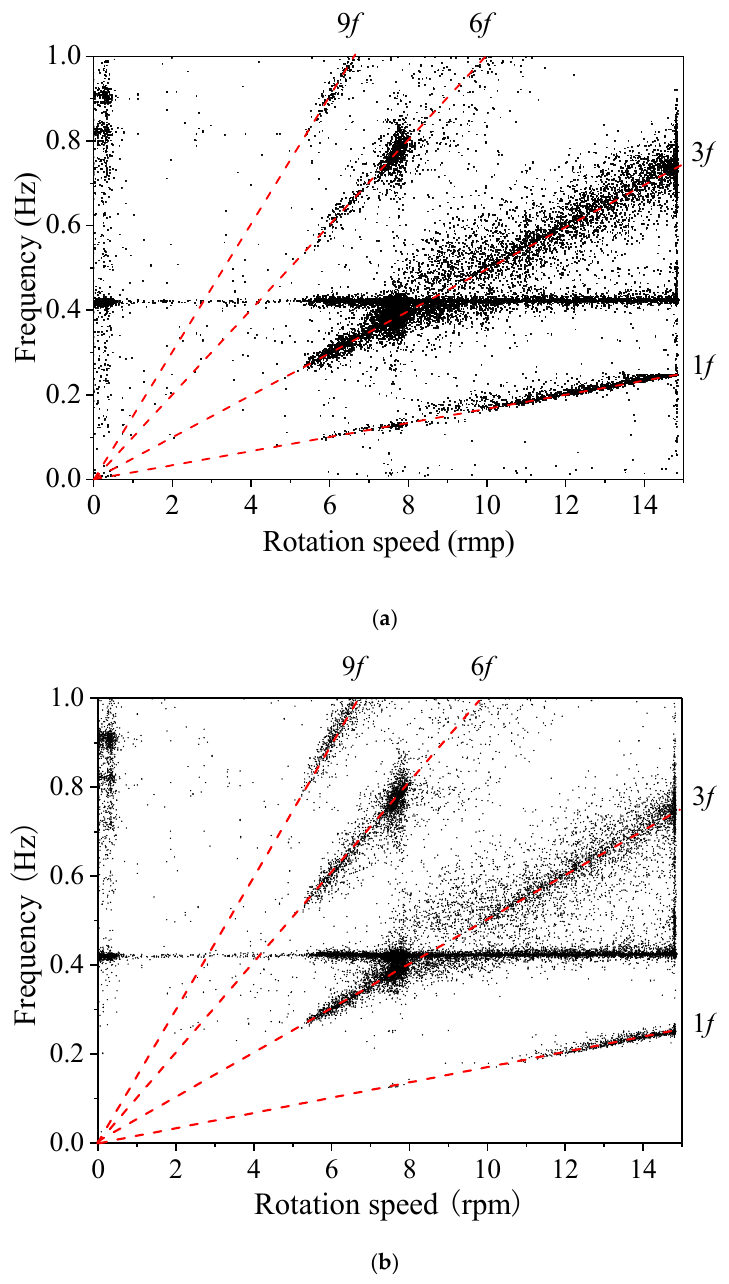
Figure 12. Analytical and experimental frequency Campbell diagram based on low filtered and re-sampled strain and acceleration responses. ( a ) Eigen frequencies estimated by the dynamic strain responses acquired from S8 and S10; ( b ) Eigen frequencies estimated by the acceleration responses acquired from